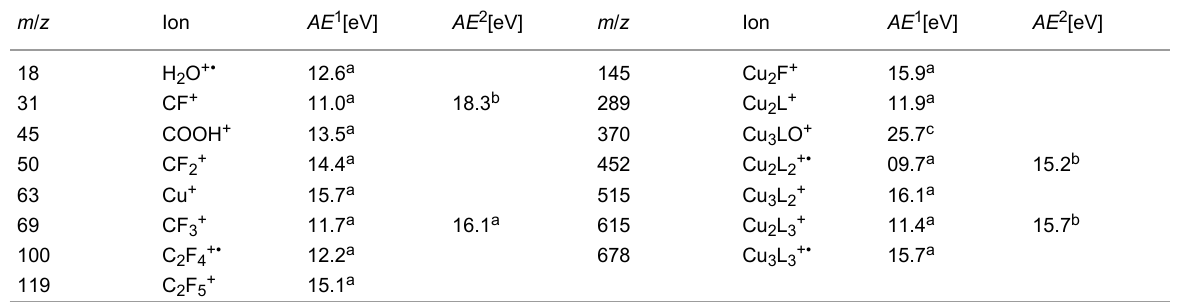
Table 1: Appearance energies for selected ions from dissociation of [Cu 2 (µ-O 2 CC 2 F 5 ) 4 ] induced by electron impact ionization. m /